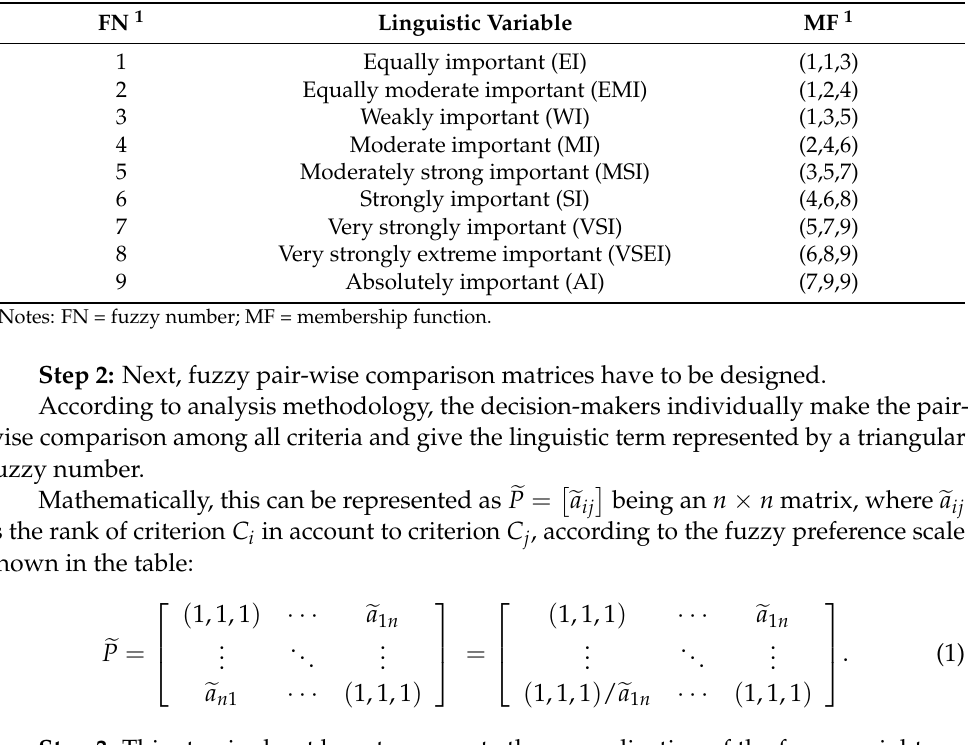
Table 1. The TFN to make pair-wise comparison matrix for the main criteria. FN 1 Linguistic Variable MF 1 1 Equally important (EI) (1,1,3) 2 Equally moderate important